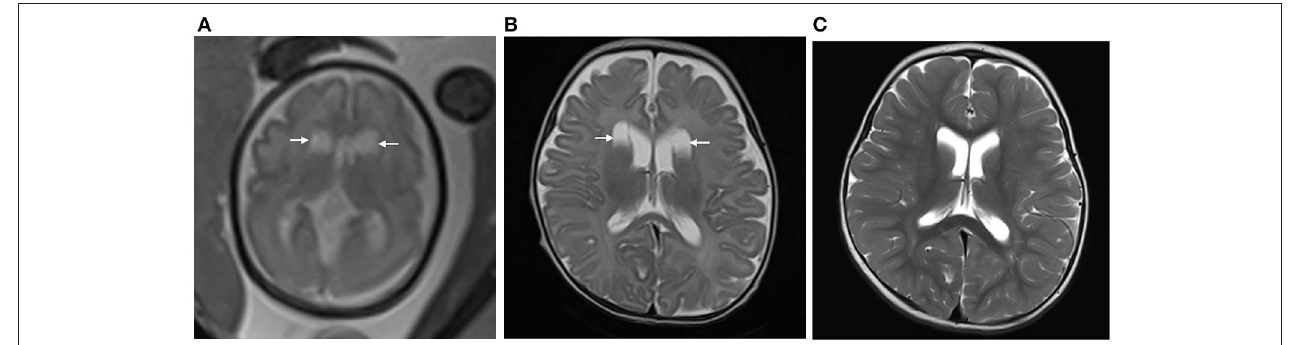
FIGURE 2 | (A) Pregnant woman, 29 years old, with a fetus of 30 weeks’ gestation. Fetal brain MRI shows bilateral isolated periventricular pseudocyst (PVPC) located at the external angle of the lateral ventricles (white arrow). The anteroposterior diameter is 1.5 and 1.6cm, respectively; (B) 40 days after birth, the cyst sizes show no significant change; and (C) At the age of 18 months, the PVPCs disappeared, and the Gesell Developmental Scale (GDS) test showed the developmental quotient (DQ: Adaptive: 96, Gross Motor: 87, Fine Motor: 89, Language: 96, and Personal-Social: 91) was normal.